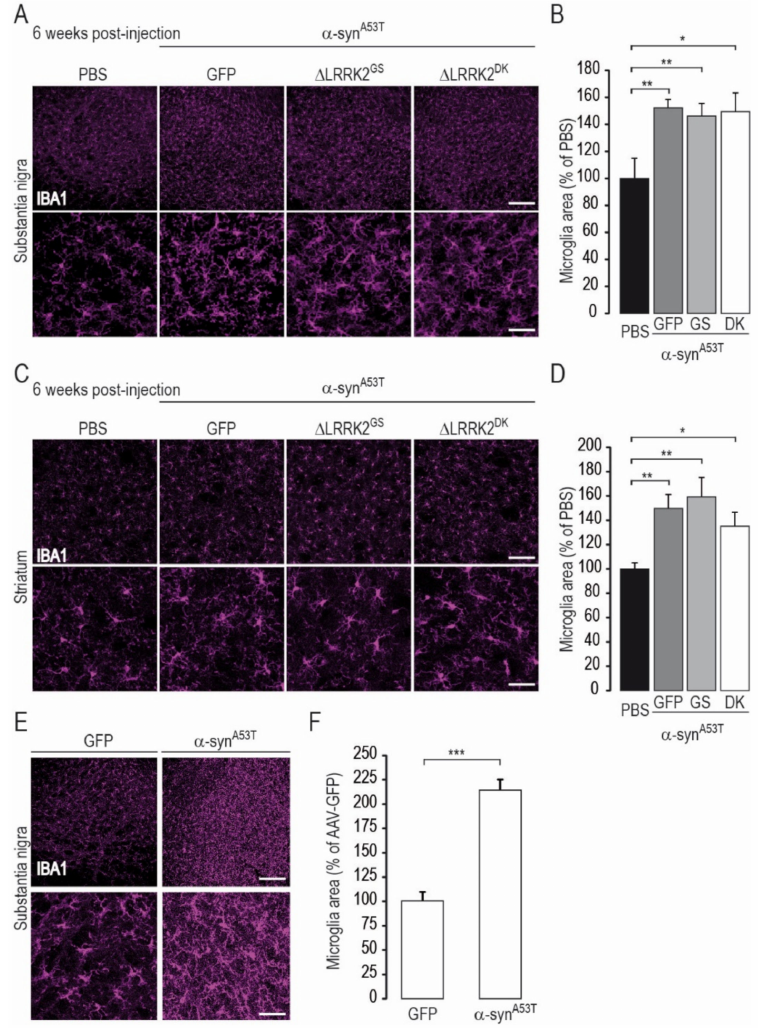
Figure 9. Microglial activation induced by α -syn A53T is not modified by overexpression of ∆ LRRK2 fragments. Histological evaluation was performed six weeks after the injection of PBS or AAV- α -syn A53T alone or AAV- α -syn A53T mixed with either AAV-GFP, ∆ LRRK2 G2019S ( ∆ LRRK2 GS ), or the dead kinase form ∆ LRRK2 G2019S/D1994A ( ∆ LRRK2 DK ). Cells positive for IBA1 were detected by immunofluorescence and confocal microscopy and their cross-sectional area was determined by image analysis. ( A ) Photomicrographs of rat brain sections labeled for IBA1 immunoreactivity in the SNpc at low (upper images) and high (lower images) magnification in the various groups. ( B ) Quantification of the mean cross-sectional area of IBA1-positive cells. ( C ) Low (upper images) and high (lower images) magnification photomicrographs of rat brain sections labeled for IBA1 immunoreactivity in the striatum of rats in which the SNpc was injected with PBS or AAV- α -syn A53T with AAV-encoding ∆ LRRK2 constructs. ( D ) Quantification of the mean cross-sectional area of IBA1- positive cells. ( E ) Low (upper images) and high (lower images) magnification photomicrographs of rat brain sections labeled for IBA1 immunoreactivity in the SNpc of rats injected with AAV-GFP or AAV- α -syn A53T alone. ( F ) Quantification of the mean cross-sectional area of IBA1-positive cells. Results are expressed as the mean percentage ± SEM of the staining of the control group (PBS in ( A – D ), AAV-GFP in ( E , F )). N = 8 animals/group in ( B – D ) and 5 to 7 animals/group in ( F ). In ( B ), ANOVA and PLSD post hoc test B (SNpc), and Kruskal–Wallis and Mann–Whitney tests in ( D ) (striatum). ( F ), Unpaired Student’s t -test. * p < 0.05, ** p < 0.01, *** p < 0.0001. Scale bar: low magnification, 200 µ m; high magnification, 50 µ